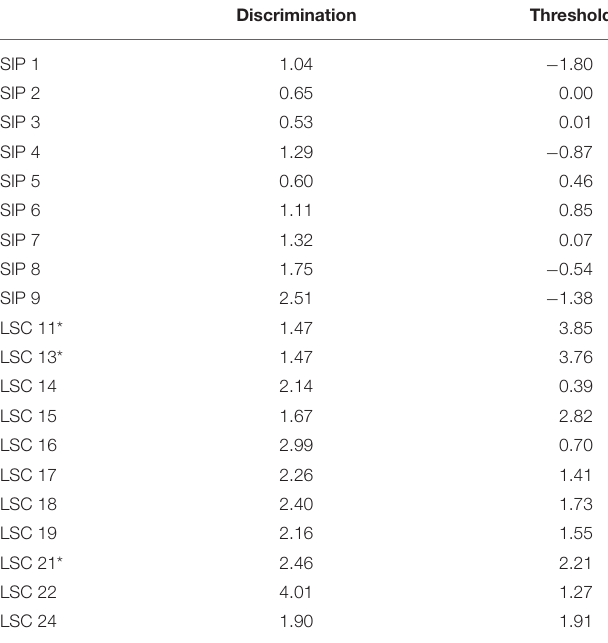
TABLE 2 | SLA items calibration results.